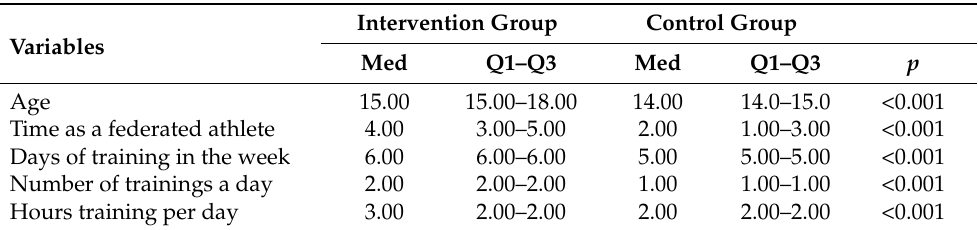
Table 1. Median, quartile, and Mann–Whitney test values referring to basketball athletes ( n = 59) grouped according to the intervention group ( n = 29) and control group ( n =